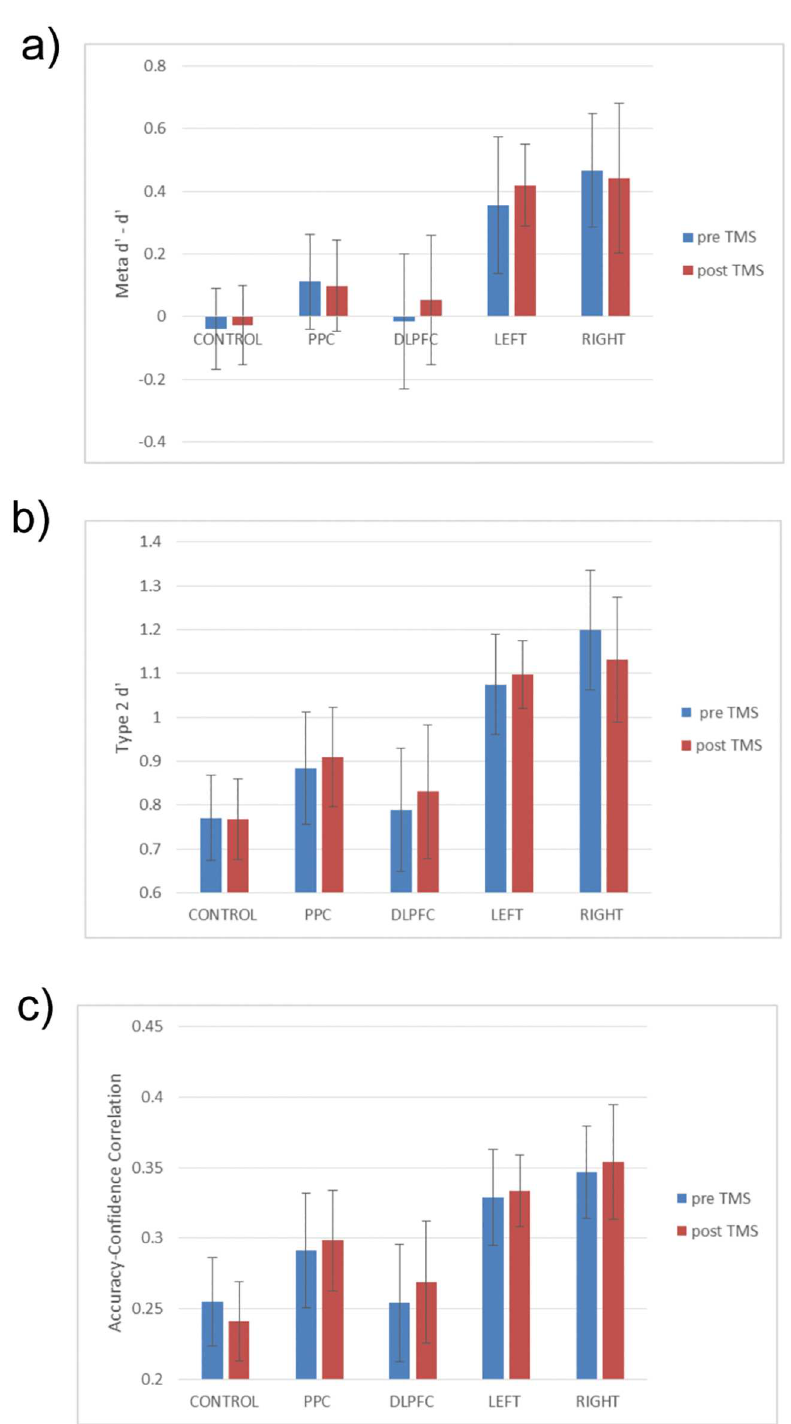
Fig 3. Metacognitive measures. Pre- and post-TMS metacognitive measures for the different groups. a) meta d’—d’. b) type II d’. c) Accuracy-confidencephi correlation.Group labels as Fig 2. All error bars are SE.